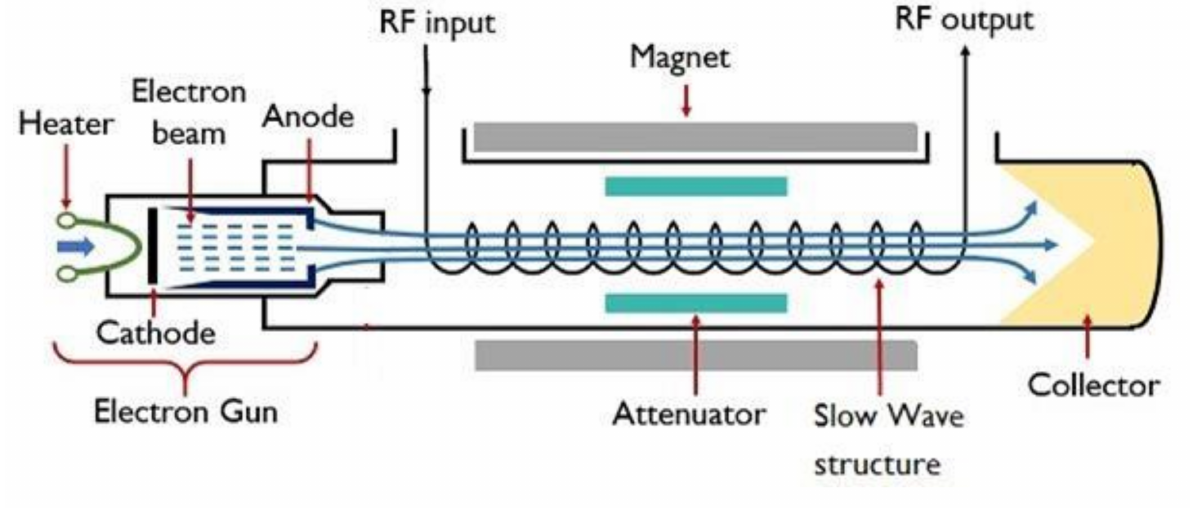
Figure 1. Constructional structure of the